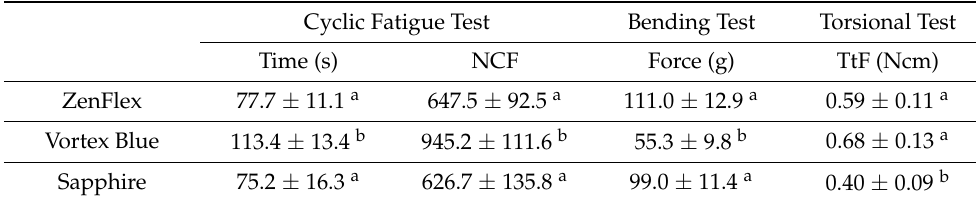
Table 1. Schematic summary of the mechanical properties of ZenFlex, Vortex Blue and EdgeSequel Sapphire instruments resulting from cyclic fatigue, bending ability and torsional resistance. Different superscript letters in the same column indicate statistical differences among groups ( p <